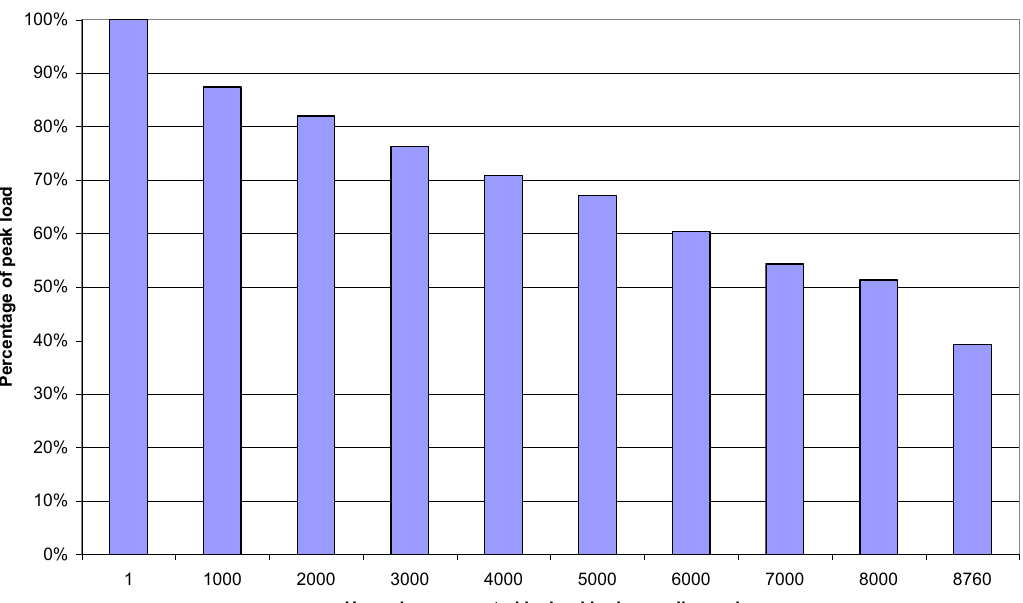
Figure 6. System load profile for Sabah electrical grid.